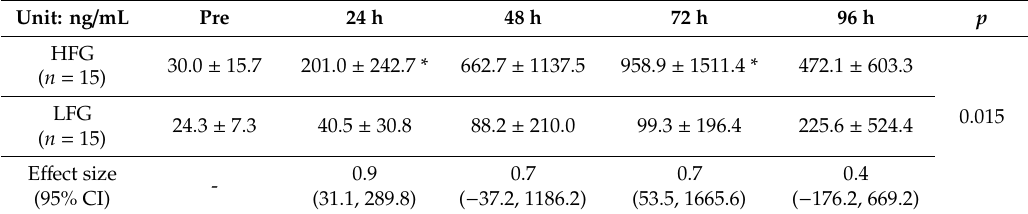
Table 6. Mb after eccentric exercise according to